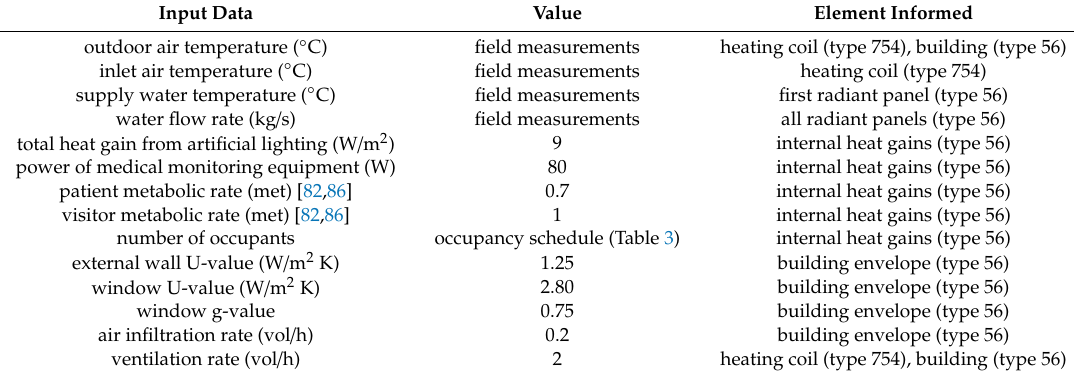
Table 4. Input data utilised for building model calibration. Value Element